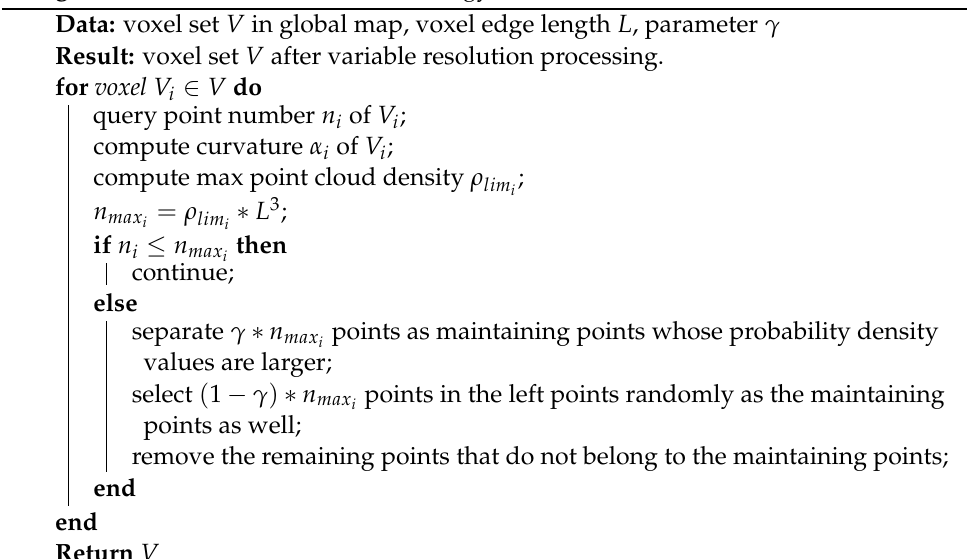
Algorithm 1: Variable Resolution